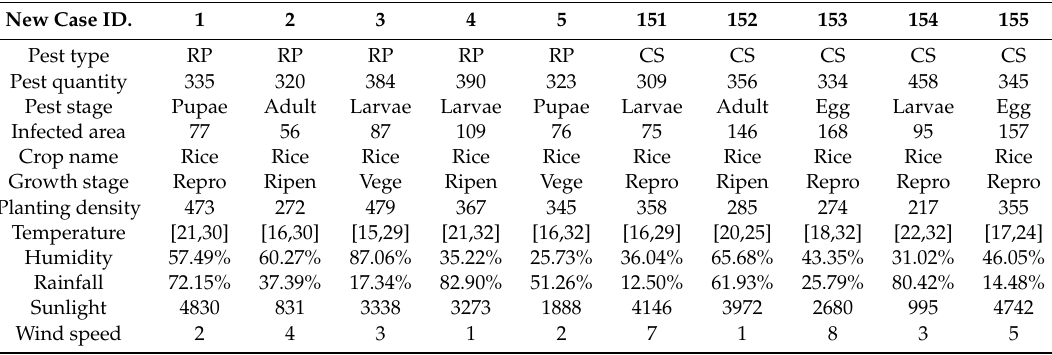
Table 2. Some data of new cases for test purposes.